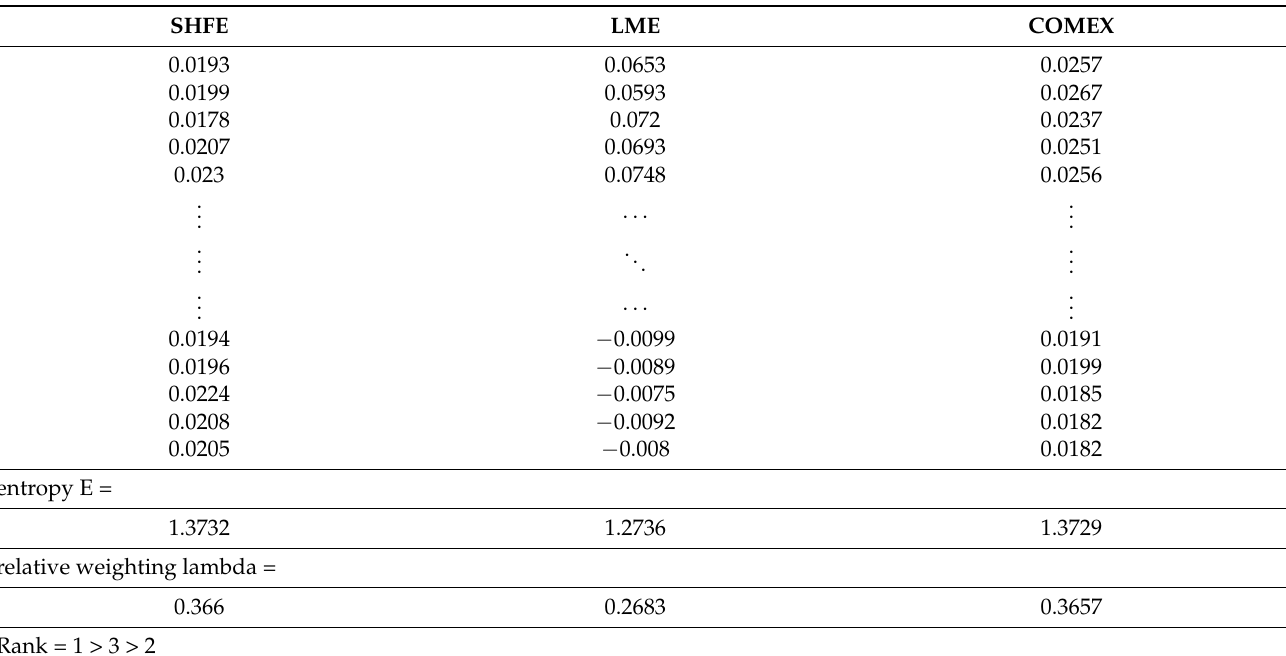
Table 12. Values from the processing of each factor after weighted analysis using grey entropy after the COVID-19